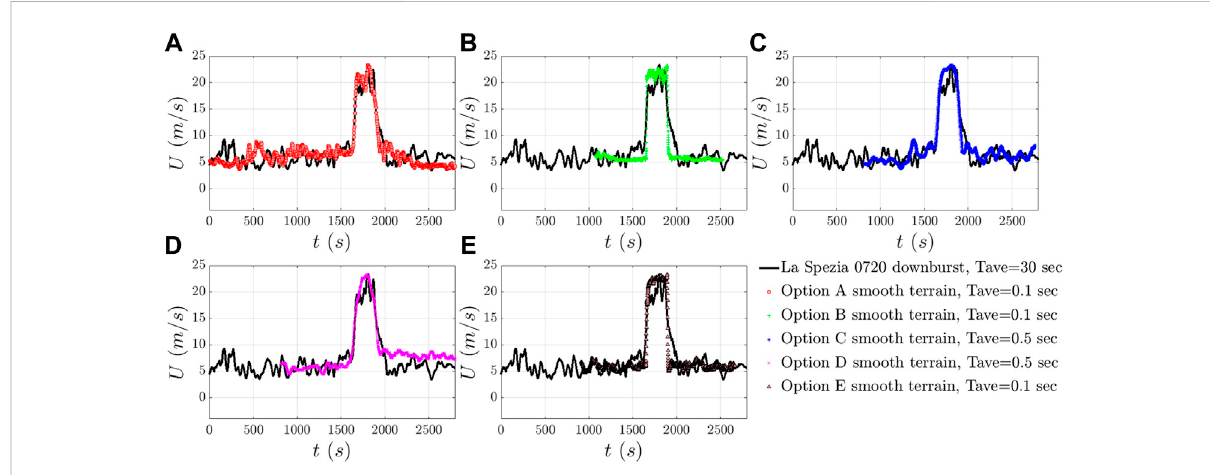
FIGURE 6 Velocity time history comparison among all downburst simulations for options a, b, c, d, e and a real downburst event Termed La Spezia 0720; courtesy of Professor Giovanni Solari and “ Wind and Ports ” and “ Wind, Ports, and Sea ”